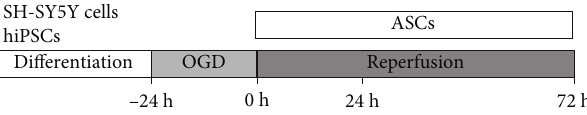
Figure 1: Timeline of the study. SH-SY5Y neuroblastoma cells and human induced pluripotent stem cells (hiPSCs) were di ff erentiated into neuronal cells. The cells were subjected to oxygen-glucose deprivation (OGD) in 1% O without glucose for 24 h. Then, the 2 cells were transferred back to normoxic (19% O ) conditions with 2 medium containing glucose for 24 or 72 h (reperfusion). To study the e ff ect of human adipose stem cells (ASCs), ASCs and neurons were cocultured after OGD for 24 or 72h. ASCs were cultured on inserts on the top of